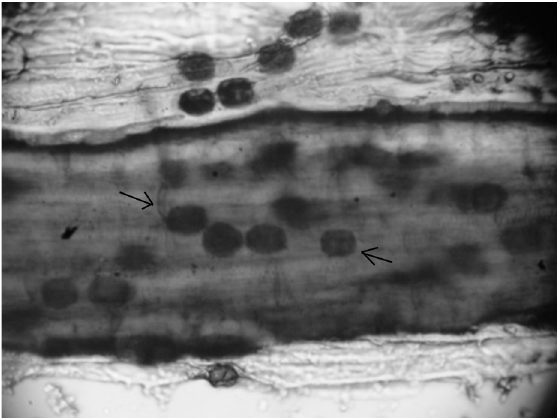
Figure 1 - Root colonized by arbuscular mycorrhizal fungi (AMFs), observed during the evaluation of the roots of D. antarctica . The arrows indicate the presence of vesicles (storage structures) inside the